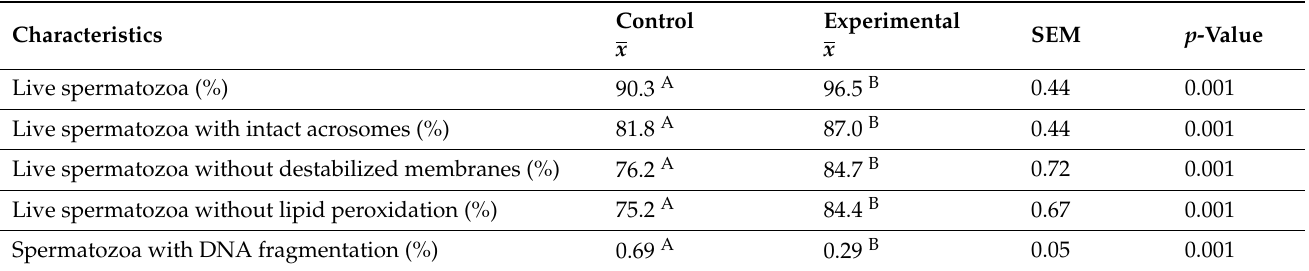
Table 4. Flow cytometric comparison of quality characteristics of fresh sperm: viability, acrosome and plasma membrane integrity, apoptotic and capacitation changes, membrane lipid peroxidation and sperm chromatin structure in boars fed diets top-dressed with linseed oil ethyl esters (mean, n = 6/group, SEM, p -value).